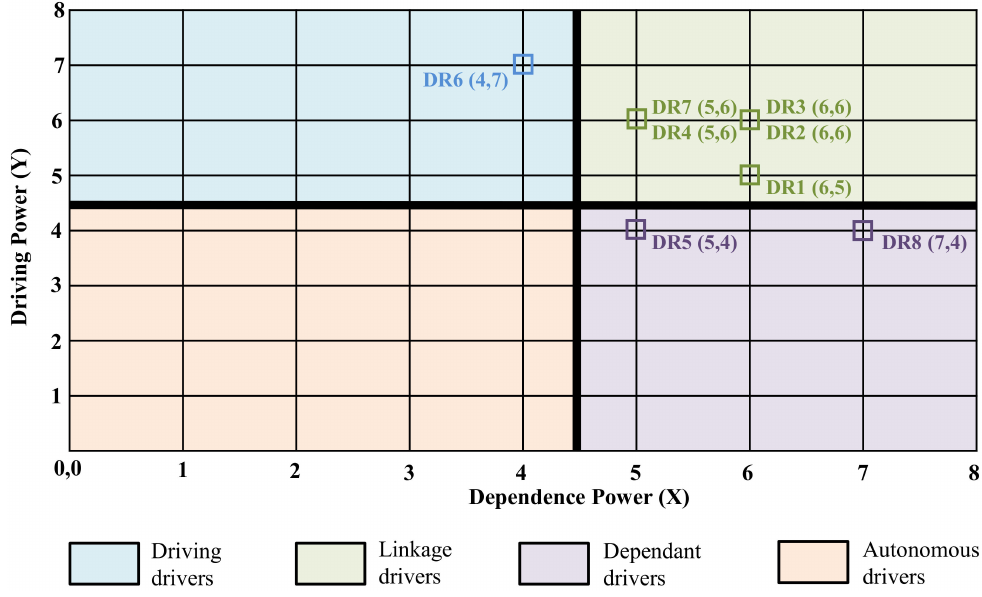
Figure 8. MICMAC analysis of the drivers of